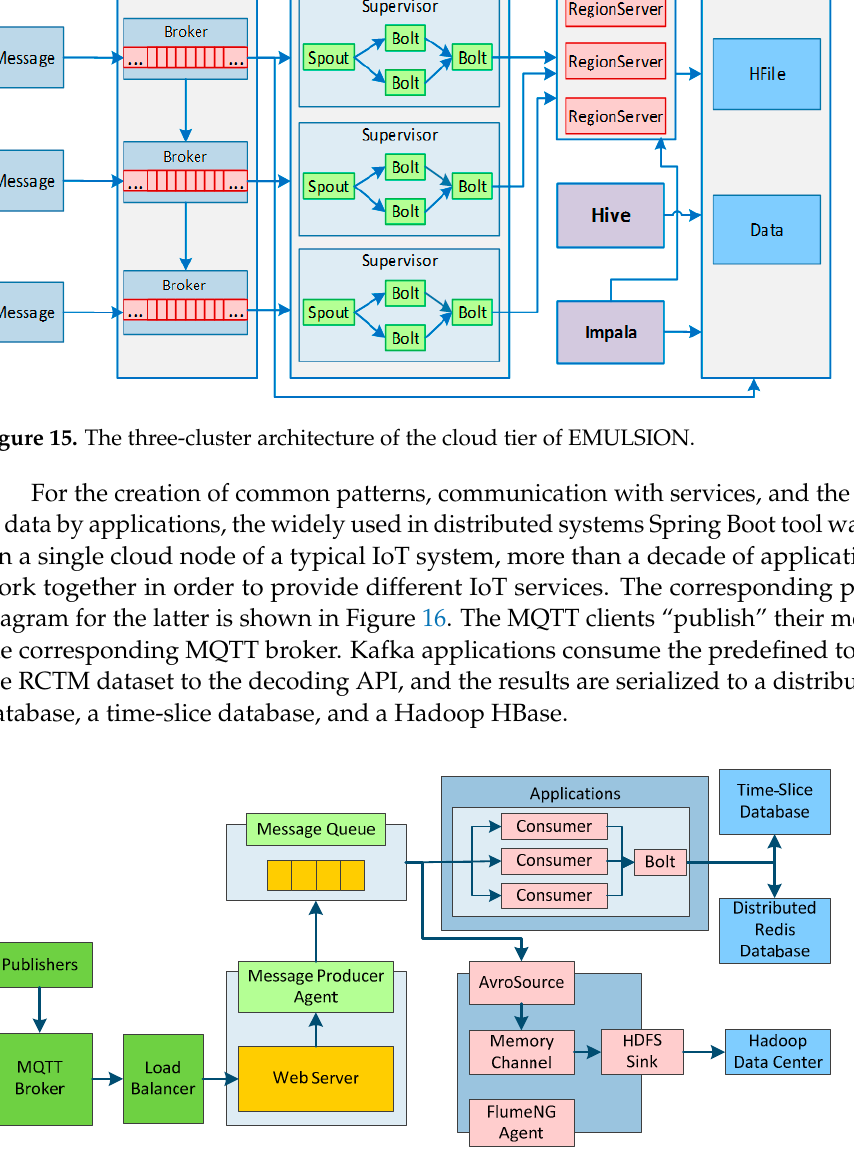
Figure 16. The software architecture of a cloud node, utilized by EMULSION.